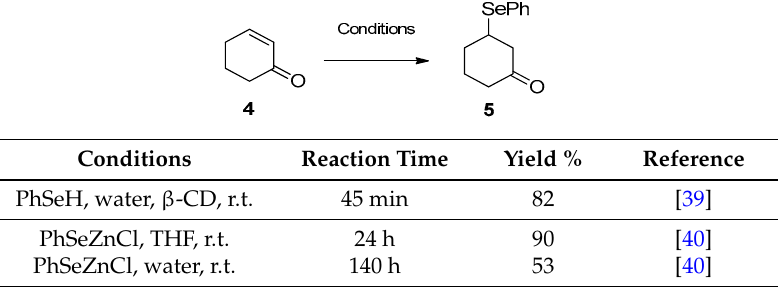
Figure 9. Vinyl selenide prepared by conjugated addition of PhSeZnCl to propargylic derivatives in “on-water” conditions (r.t., 2 h). Vinyl selenides can be obtained from PhSeZnCl using water as a reaction medium also toward vinyl substitution of the corresponding vinyl halides. The reaction in water is considerably faster than in THF and in all cases a stereo-retention on the geometry of the double bond was observed. Only in the case of the electron-deficient vinyl chloride 6 did the substitution from Z and E isomer occur with a stereo-convergent mechanism, producing Z - 8 as a unique or major isomer. This aspect has been investigated using DFT calculation, which shows that the substitution passes through